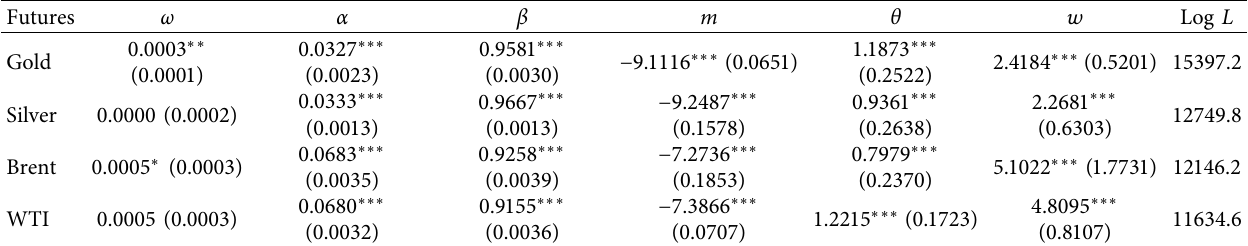
Table 4: Estimation results of GARCH-MIDAS +ID-EMV models of futures volatility by infectious disease with 9-month lags. Futures ω α Log L Gold